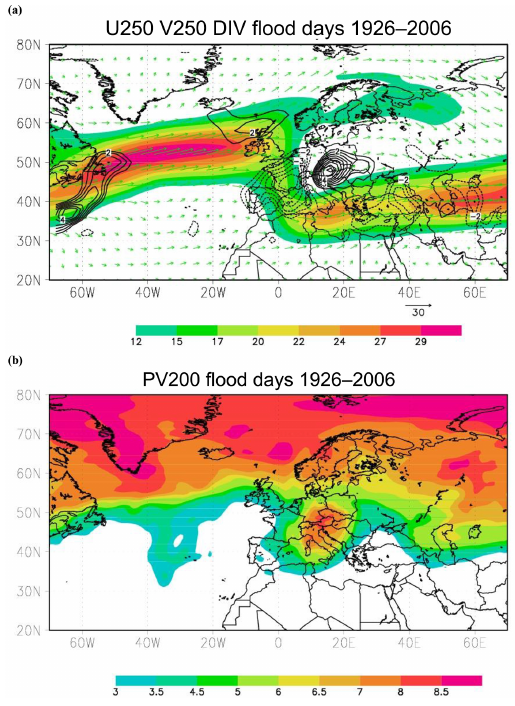
Figure 3. Composite map of (a) the 250hPa wind (vector), its mag- nitude (color) and divergence (contour) for Ammer flood days for the period 1926–2006 and (b) composite map of 200hPa potential vorticity for flood days during 1979–2006. Units: U250 (ms − 1 ), divergence (10 − 6 s − 1 ) and potential vorticity